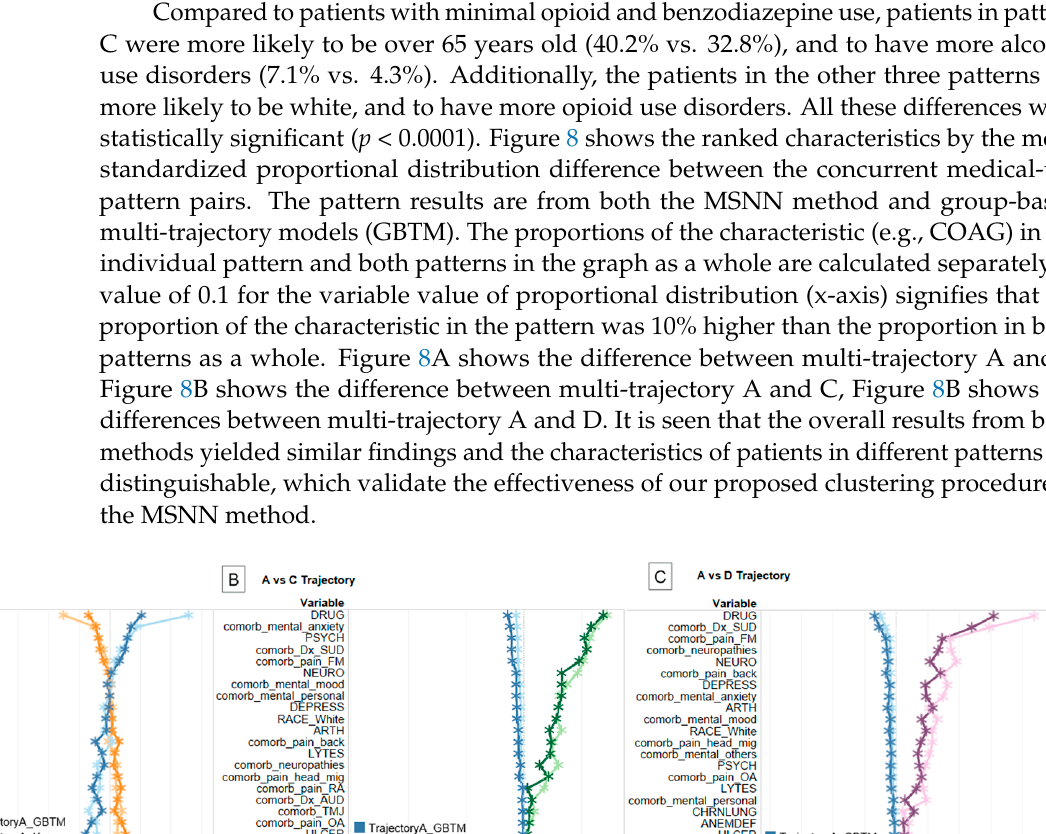
Figure 7. Multi-trajectory patterns of medical use.